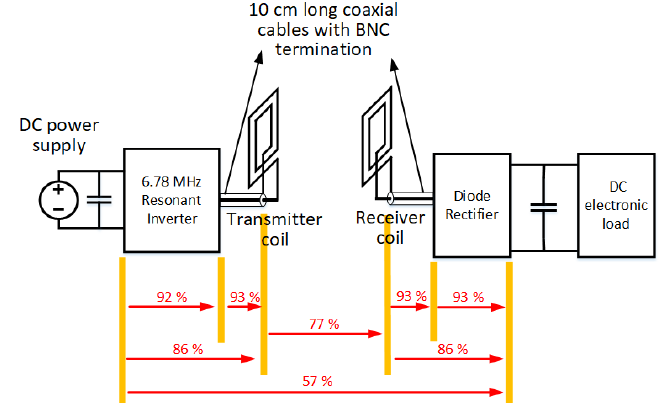
Figure 15. Configuration of the test-bed.